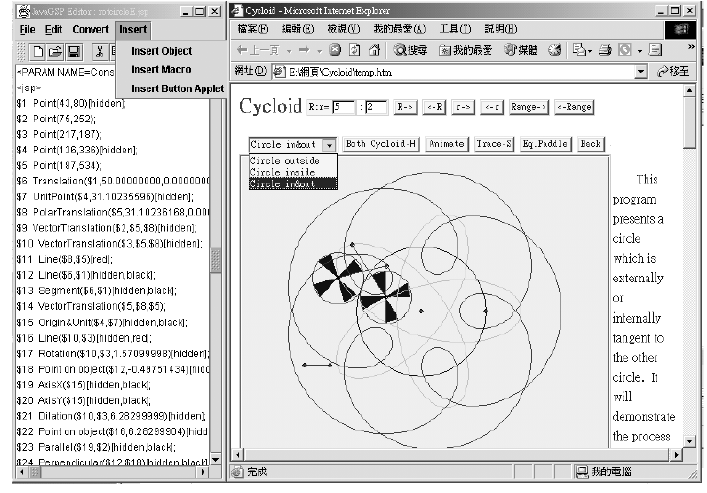
Figure 1. JavaSketchpad Editor (the left is Editor, viewer in the right (Lin,